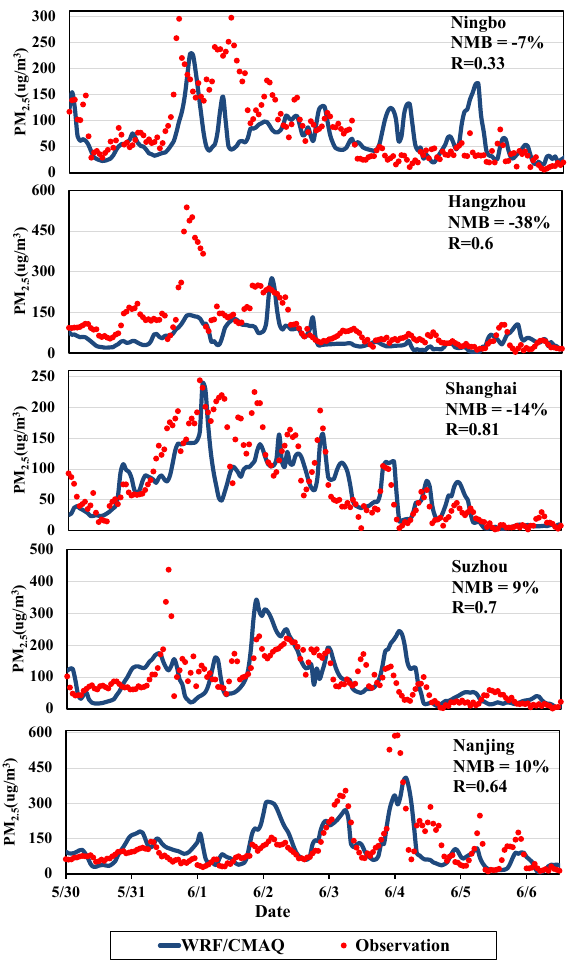
Fig. 8. Comparison of CMAQ simulations (blue lines) and TEOM–measured (red dots) hourly PM 2.5 mass concentrations. NMB means normalized mean bias. R means the correlation coefficient.